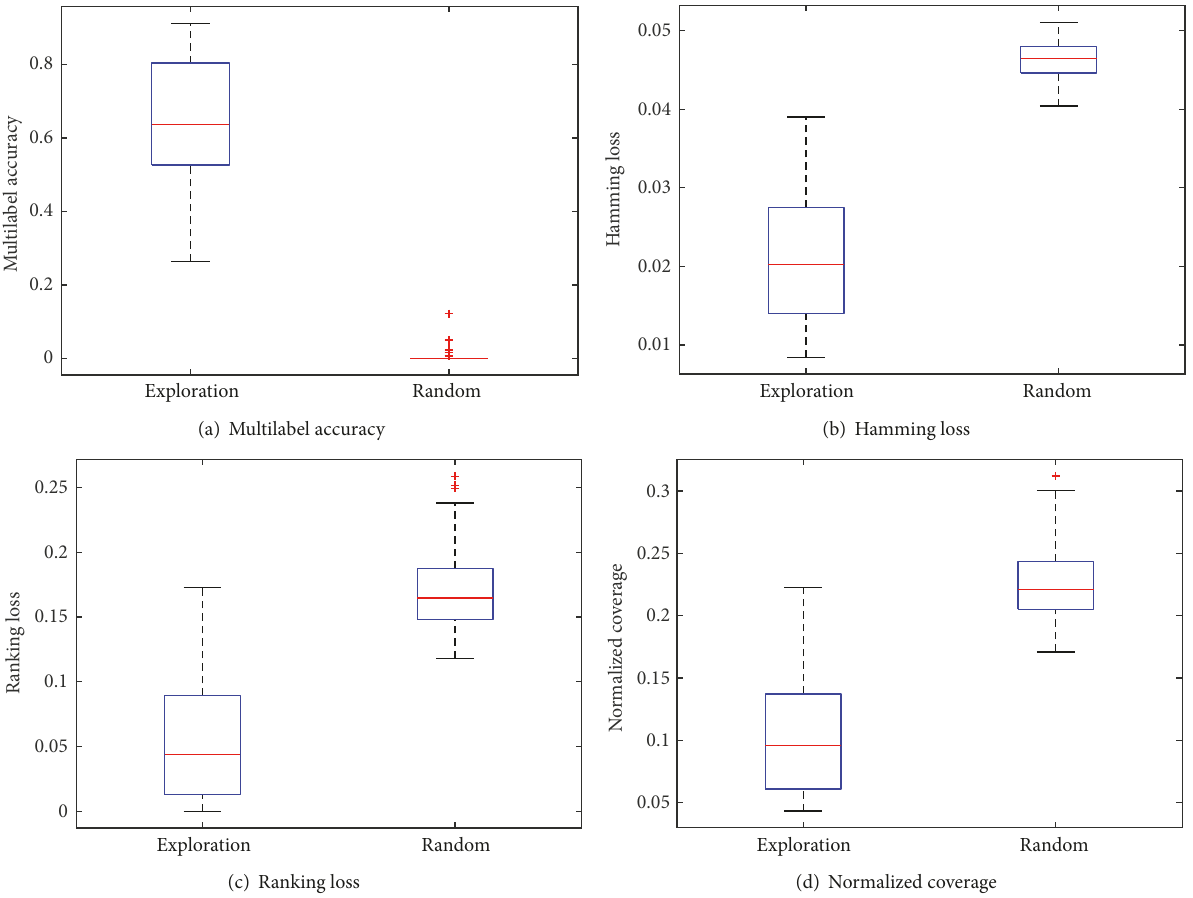
Figure 3: Comparison results showing the effectiveness of the proposed exploration operator and random search in terms of the four performance measures on the Genbase